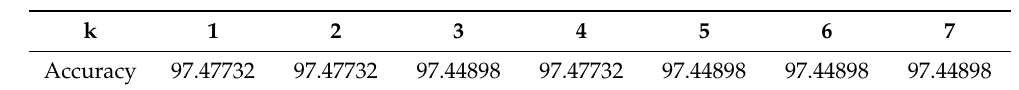
Table 4. k tested for selection for the k-NN